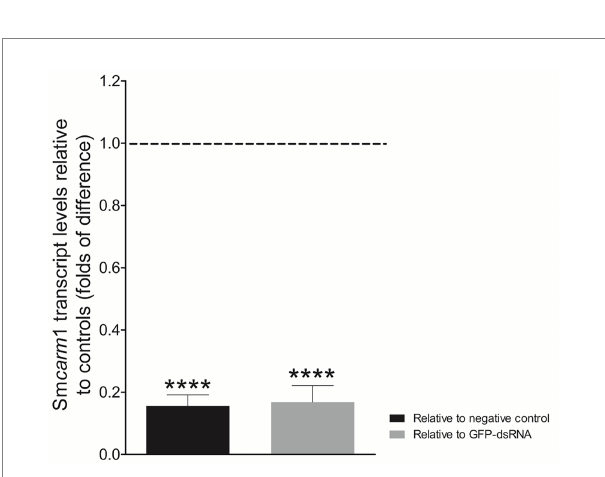
FIGURE 2 Sm carm 1 transcript levels in schistosomula after dsRNA exposure. Bar graph depicting the Sm carm 1 transcript levels in schistosomula after 7 days of exposure to Sm carm 1-dsRNA relative to negative (black) or unspecific GFP-dsRNA (gray). Data are represented as mean fold-difference (±SE) relative to controls (dashed line). Mann– Whitney test. **** p <